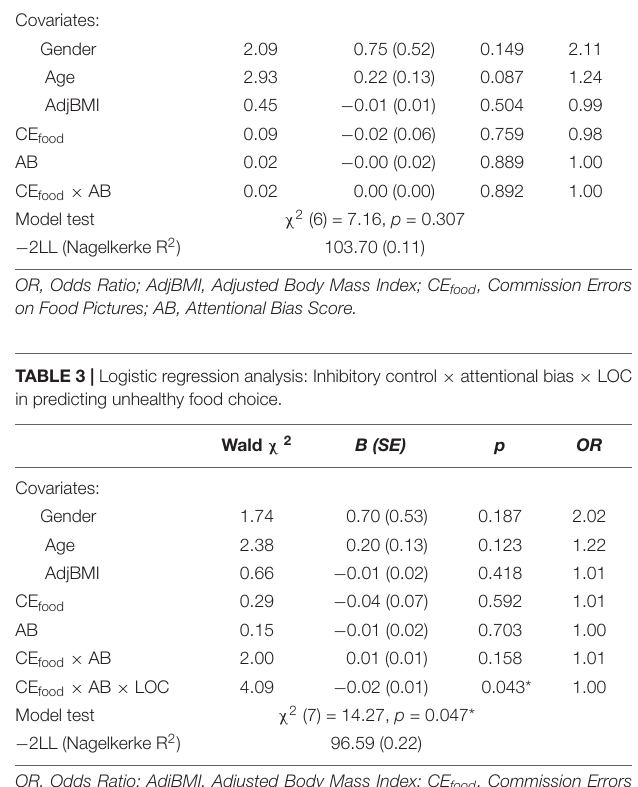
TABLE 2 | Logistic regression analysis: Inhibitory control × attentional bias in predicting unhealthy food choice. Wald χ 2